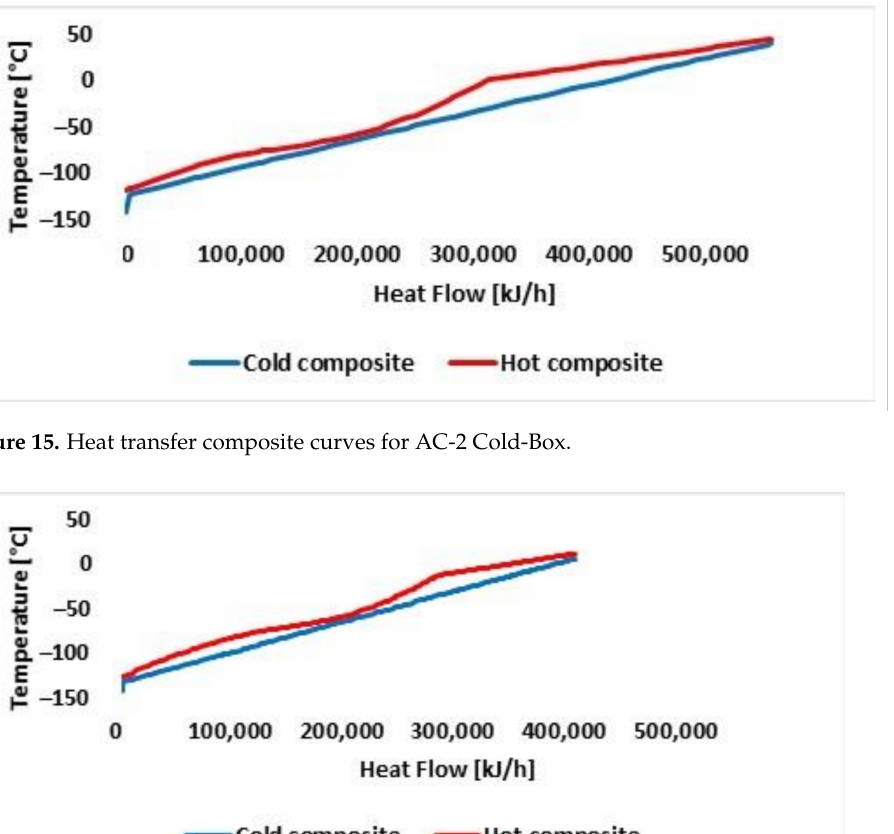
Figure 14. Heat transfer composite curves for AC-1 Cold-Box.